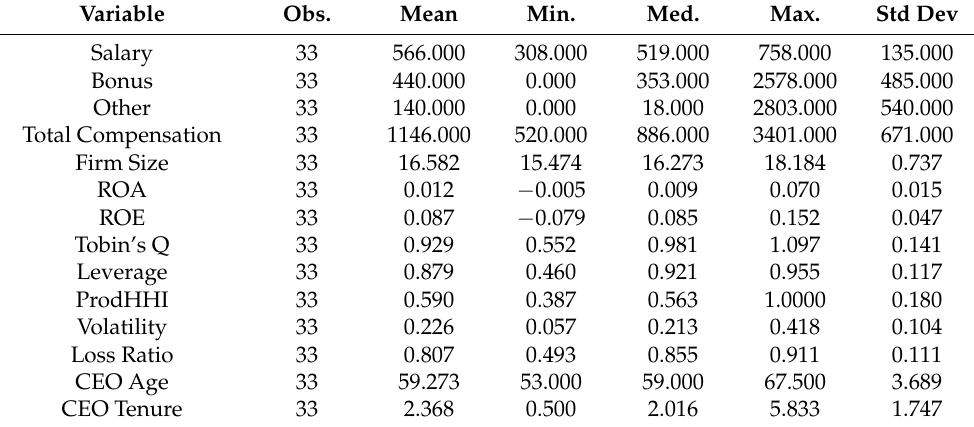
Table 2. Summary Statistics of Variables (Korean Non-life Insurance